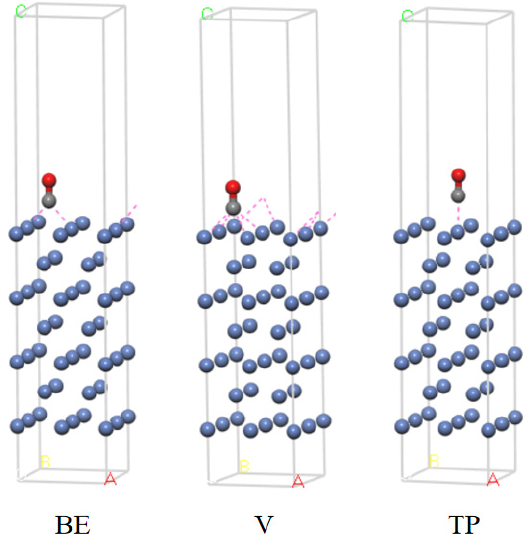
Figure 3. Three adsorption models of a CO and Ni (100) crystal surface. Table 2. Energy of CO in the free state and the energy of the three nickel crystal surface